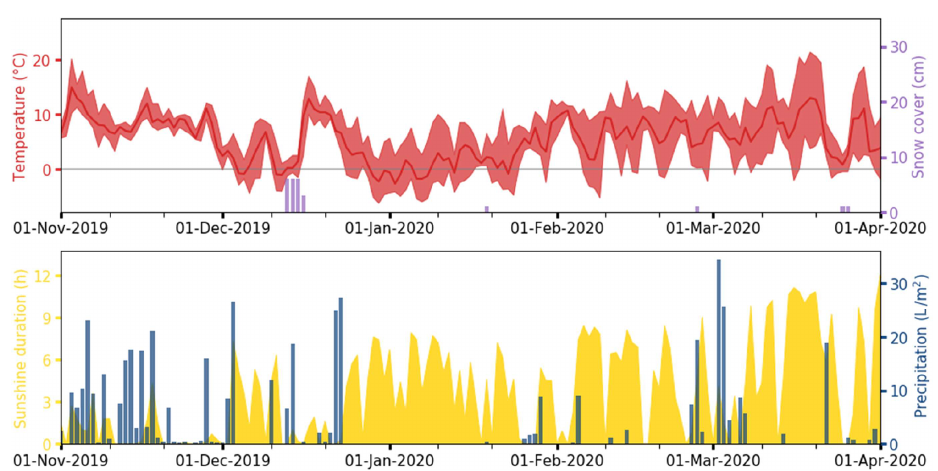
Figure 2. Time series of minimal, mean, and maximal daily temperatures, snow cover, daily sunshine duration and daily precipitation accumulation in Ljubljana from November 2019 to March 2020.